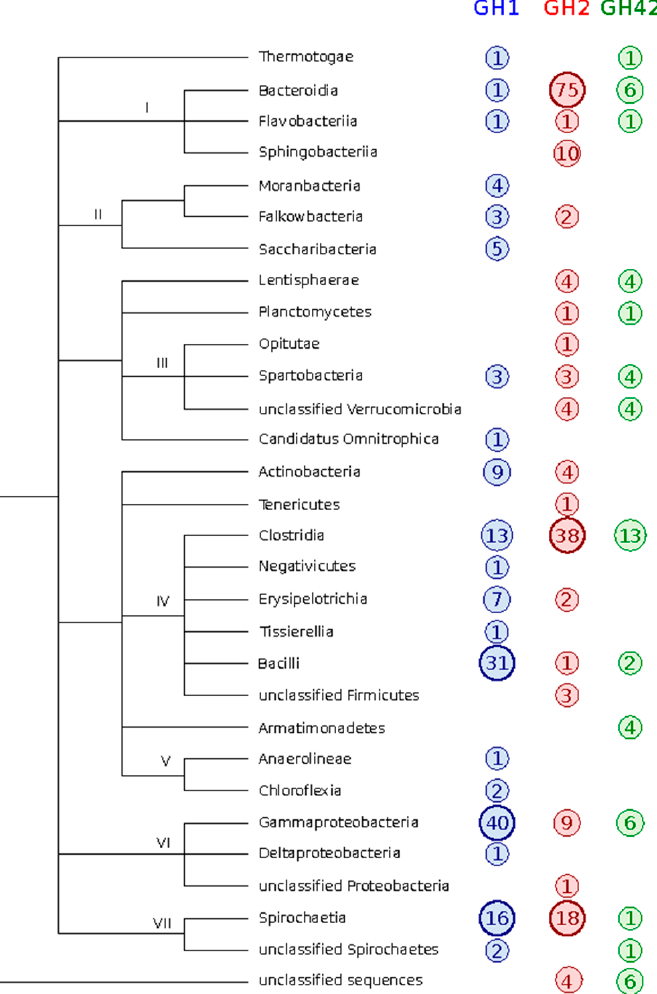
Figure 1. Taxonomic classification of the GH found. All the candidates GH were classified to the class level, using the best hit of BLAST against the nr database. I, Bacteroidetes ; II, Patescibacteria ; III, Verrucomicrobia ; IV, Firmicutes ; V, Chloroflexi ; VI, Proteobacteria ; VII, Spirochaetes .